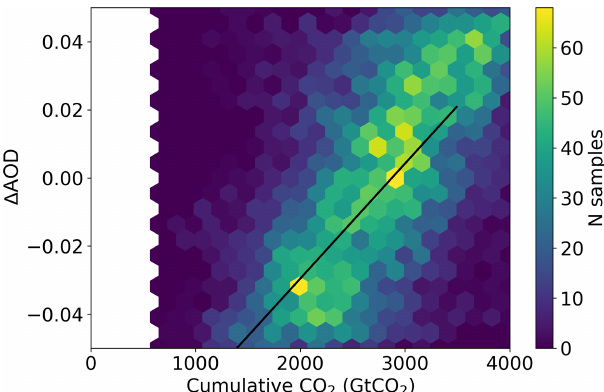
Figure 6. The joint probability distribution for a change in aerosol optical depth (AOD) or cumulative atmospheric CO 2 concentra- tion relative to the 2015–2020 average compatible with a change of 1.2K global mean surface temperature (approximately 2 ◦ above pre-industrial temperatures) as sampled from a Gaussian process emulator using MCMC accounting for emulator uncertainties. The solid black line corresponds to a change of 1.2K by interpolating the emulator surface shown in Fig.